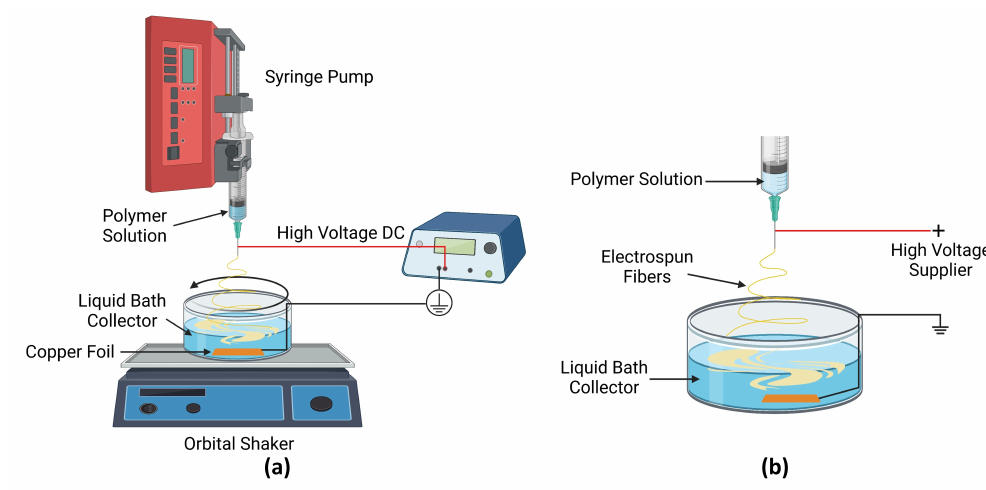
Figure 1. The schematic of experimental setup for wet electrospinning of polymer nanofibers: ( a ) Experimental setup. ( b ) Schematic between the needle and the liquid bath collector. The polymer solution is varied between Polyacrylonitrile (PAN) and Poly(ethylene oxide) (PEO) to investigate the effect of polymer type. The liquid-bath collector is varied between DI water and water glass to investigate the effect of collection bath. The orbital shaker was employed to agitate the liquid bath for fiber-dispersion